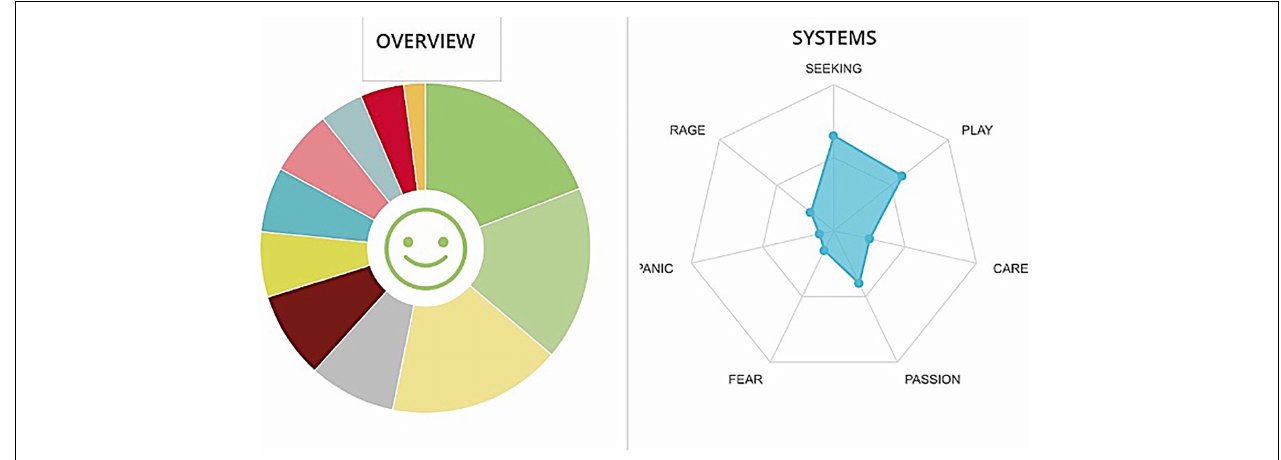
FIGURE 5 | Graphs GA. The cumulative percentages of choice of emotions made by a team are represented in the pie chart (Different colors match to the different emotions as they are displayed in Figure 1 ) while the web graph shows the correspondence between chosen emotions and emotional systems.